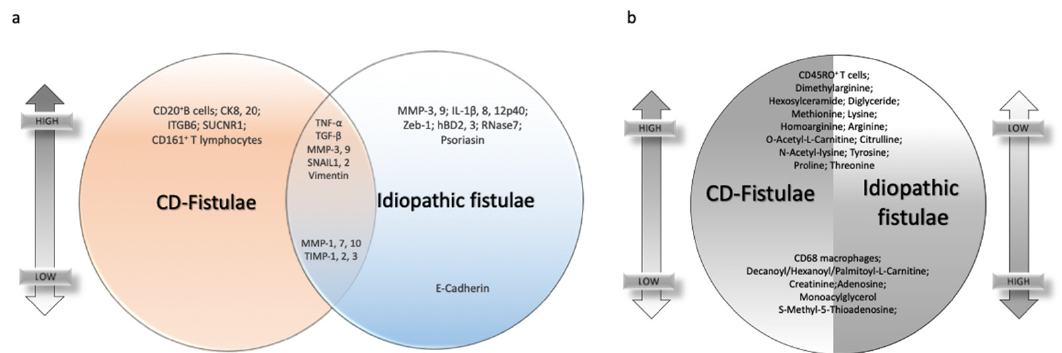
Figure 2. Common and dissimilar signatures between CD- and idiopathic fistulae. ( a ) Venn diagram highlighting individual or common markers expression in CD-related fistulae and idiopathic ones, on the top if they are upregulated, on the bottom if they are downregulated. ( b ) Differential markers expression in CD-related fistulae versus idiopathic fistulae. On the right of the circle, the expression is lower on the top of the graph and higher on the bottom. Vice versa, on the left part of the circle, the expression of the same markers is higher on the top and lower on the bottom.